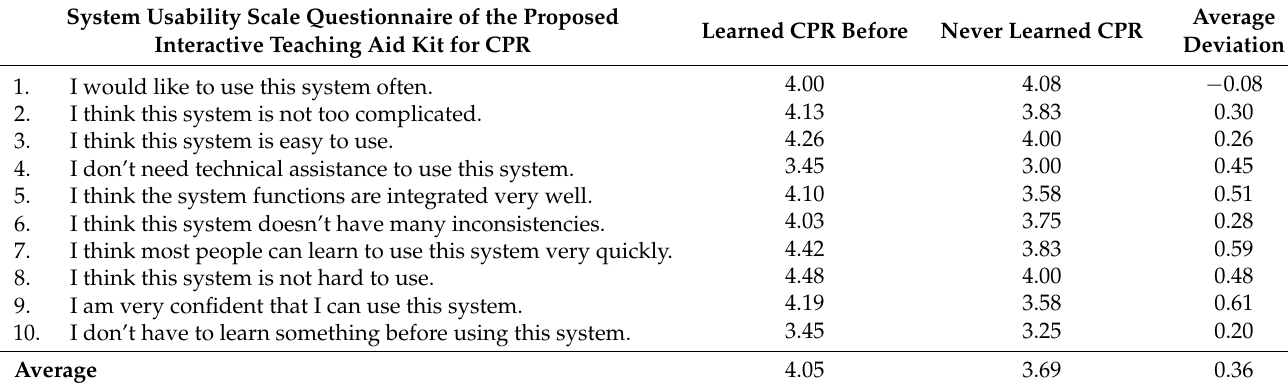
Table 5. The analysis of the questionnaire in users who have learned CPR before.